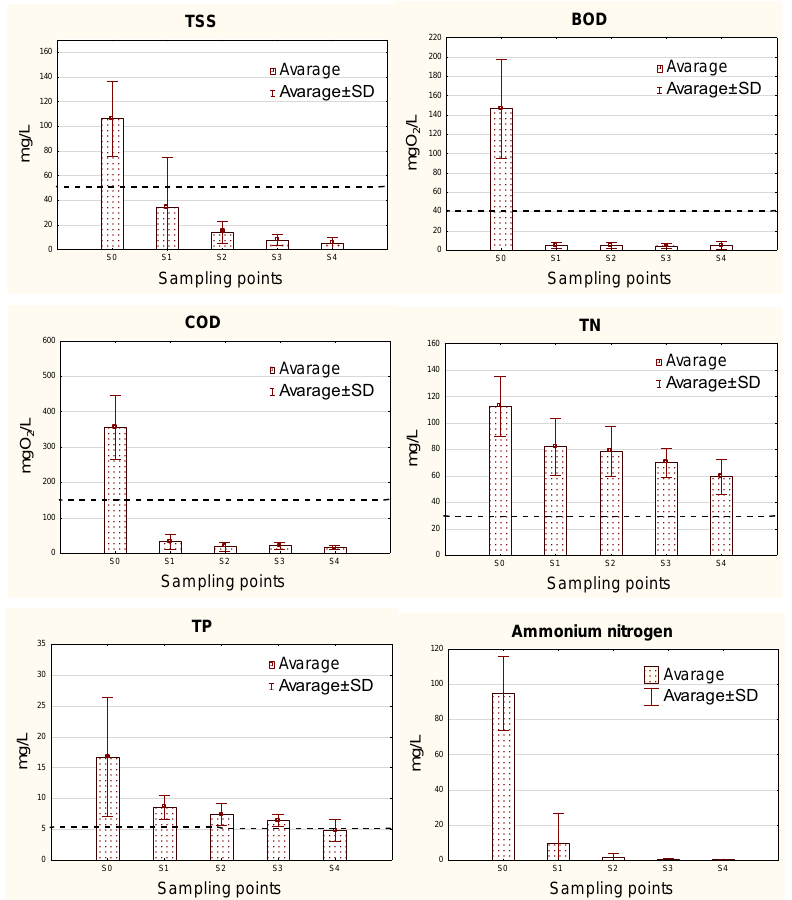
Figure 3. Dynamics of reduction of pollutant concentrations in the successive stages of treatment. Notation: dashed black line—Polish requirements for wastewater discharged into water and soil from treatment plants below 2000 PE [22].